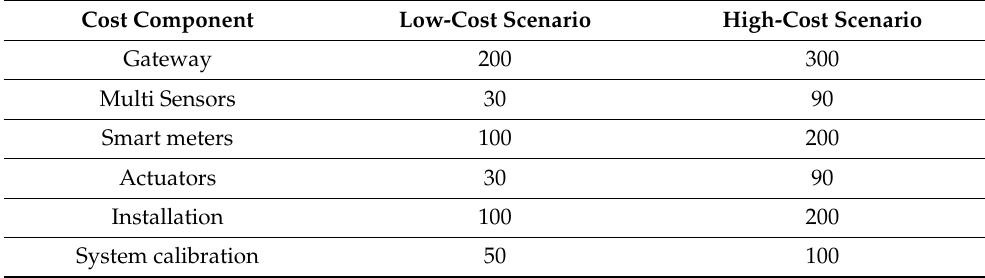
Table 7. Cost of equipment and O and M in euros (EUR). Cost